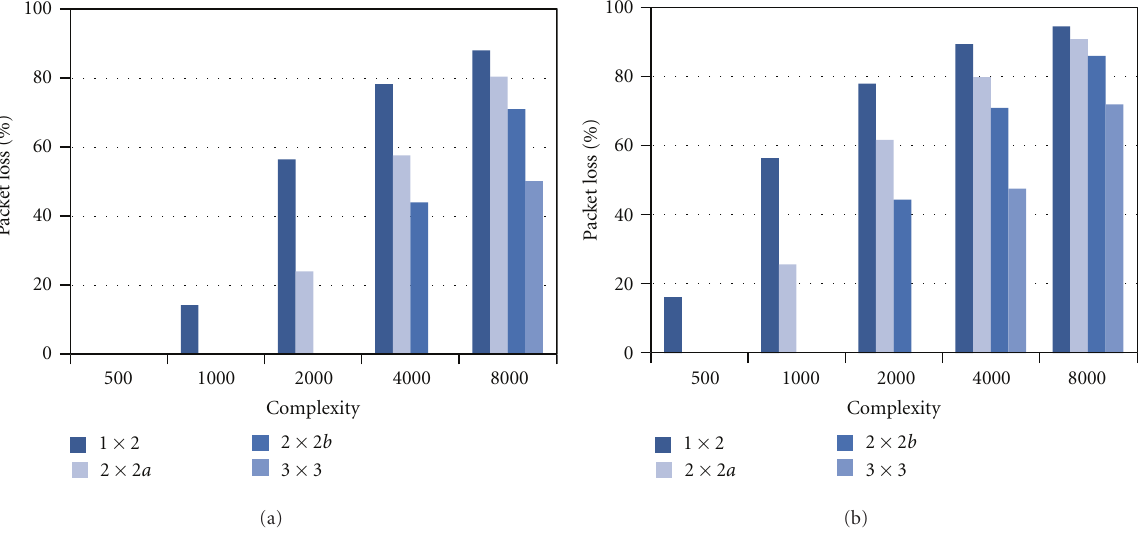
Figure 14: Dummy application: 500 Pkt/s (a) and 1000 Pkt/s (b).